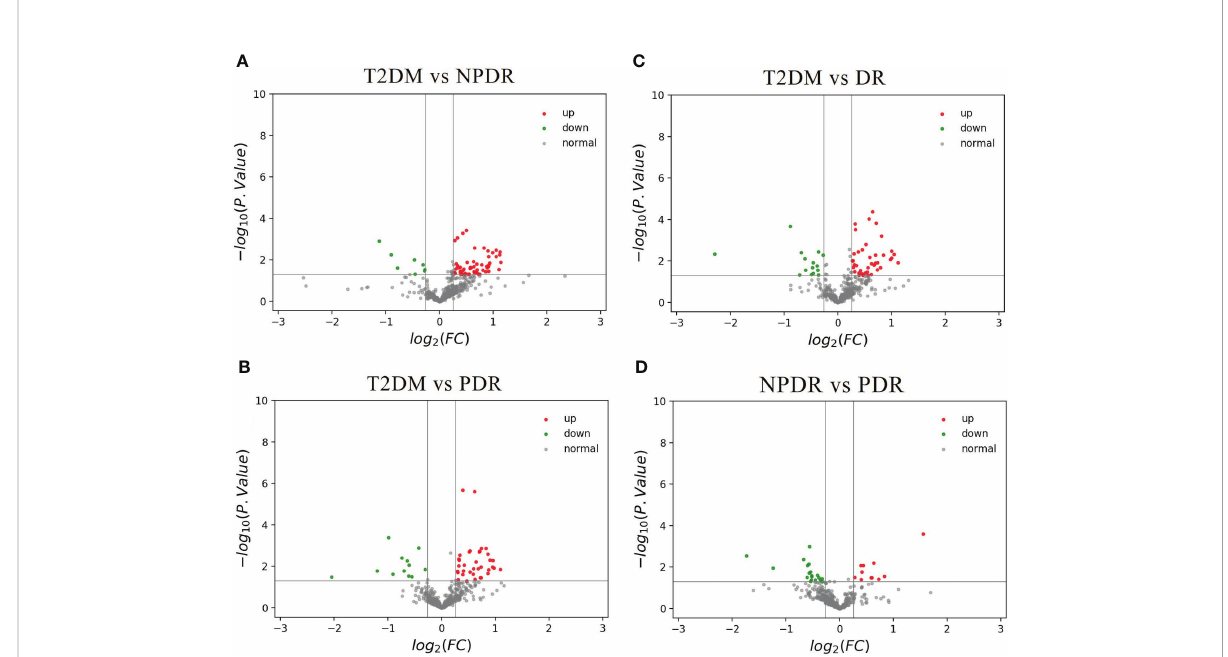
FIGURE 5 (A) The volcano map of the log2 (FC) and − log10 (p-value) showed that 65 differential metabolites were signi fi cantly different between T2DM samples (n = 9) and NPDR samples (n = 10). Compared with NPDR samples, 57 metabolic features were signi fi cantly increased (red dots) and 8 metabolic features were signi fi cantly decreased (green dots) in T2DM samples. (B) The volcano map of the log2 (FC) and − log10 (p-value) showed that 48 differential metabolites were signi fi cantly different between T2DM samples (n = 9) and PDR samples (n = 10). Compared with PDR samples, 36 metabolic features were signi fi cantly increased (red dots) and 12 metabolic features were signi fi cantly decreased (green dots) in T2DM samples. (C) The volcano map of the log2 (FC) and − log10 (p-value) showed that 56 differential metabolites were signi fi cantly different between T2DM samples (n = 9) and DR samples (n = 20). Compared with DR samples, 41 metabolic features were signi fi cantly increased (red dots) and 15 metabolic features were signi fi cantly decreased (green dots) in T2DM samples. (D) The volcano map of the log2 (FC) and − log10 (p-value) showed that 31 differential metabolites were signi fi cantly different between NPDR samples (n = 10) and PDR samples (n = 10). Compared with PDR samples, 12 metabolic features were signi fi cantly increased (red dots) and 19 metabolic features were signi fi cantly decreased (green dots) in NPDR samples. FC, fold change; T2DM, type 2 diabetes mellitus; NPDR, non-proliferative diabetic retinopathy; PDR, proliferative diabetic